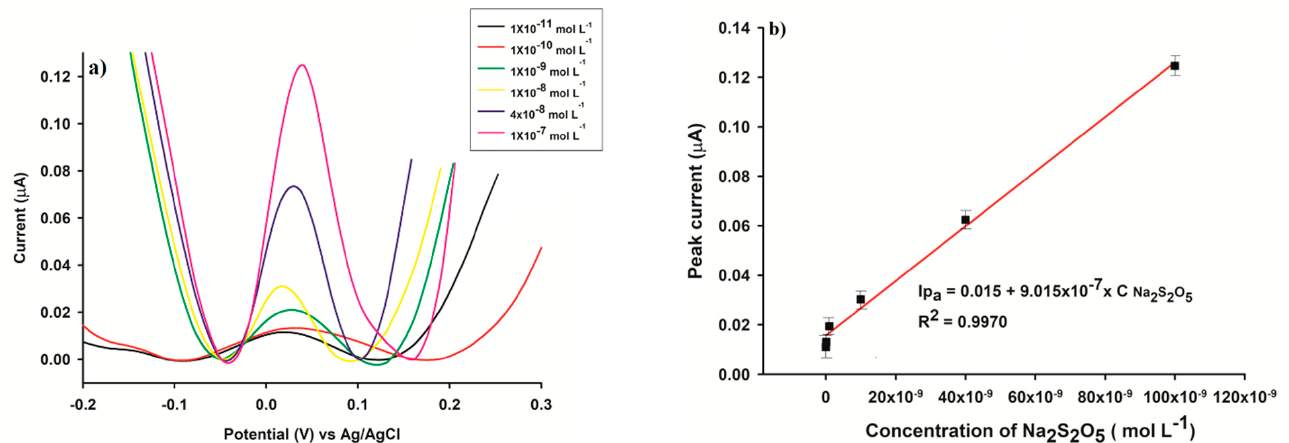
Figure 6. ( a ) Square wave voltammograms recorded with the TPP/rGO@Pd0 sensor in PBS pH 4.5 containing different concentrations of Na 2 S 2 O 5 from 1.0 × 10 − 11 mol L − 1 to 1.0 × 10 − 7 mol L − 1 . ( b ) Calibration curve obtained with the TPP/rGO@Pd0 sensor from 1.0 × 10 − 11 mol L − 1 to 1.0 × 10 − 7 mol L − 1 . Working conditions: step potential, 0.03 V; amplitude, 0.1 V; and frequency, 10 Hz. Table 1. Response characteristics of the electrochemical sensors used for detection of sodium meta- bisulfite.